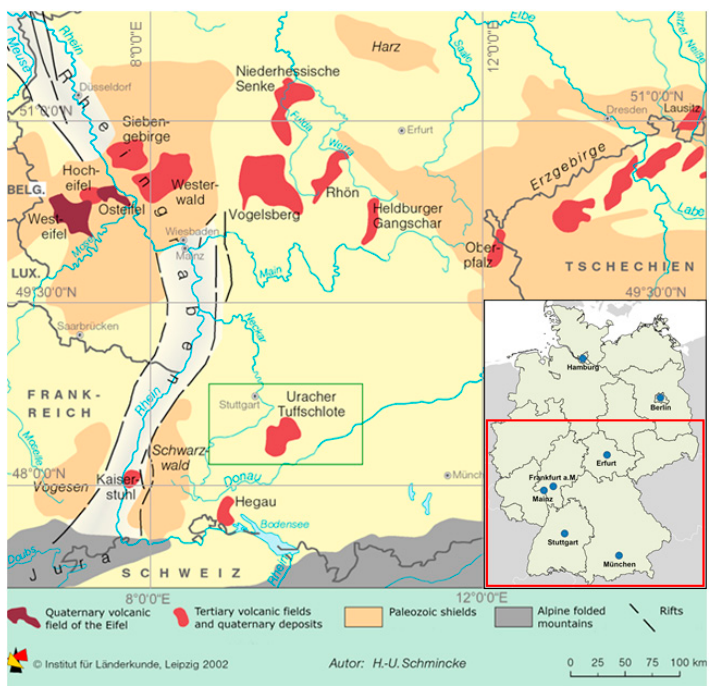
Figure 1. Regions with extinct volcanism in Germany (Author’s design, based on [18]).